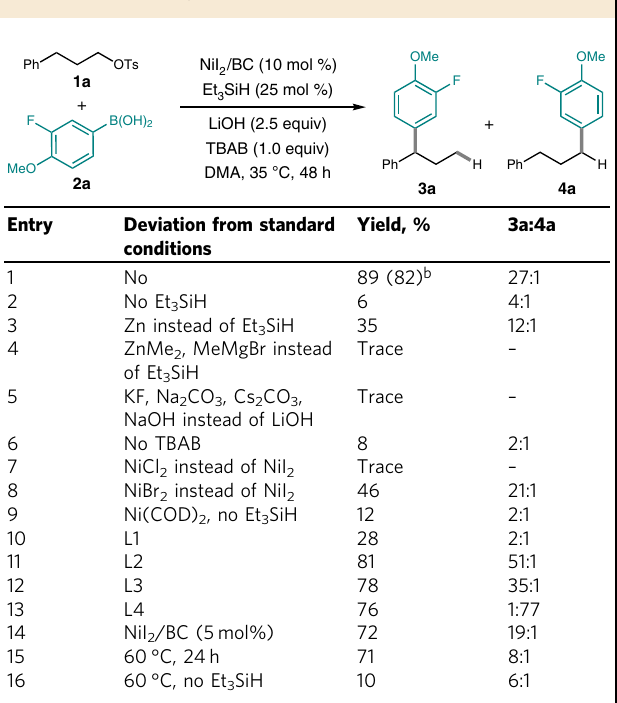
Table 1 Reaction optimization a